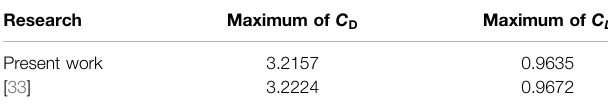
TABLE 1 | Comparison between the present results and the available in the literature for the problem with a bare